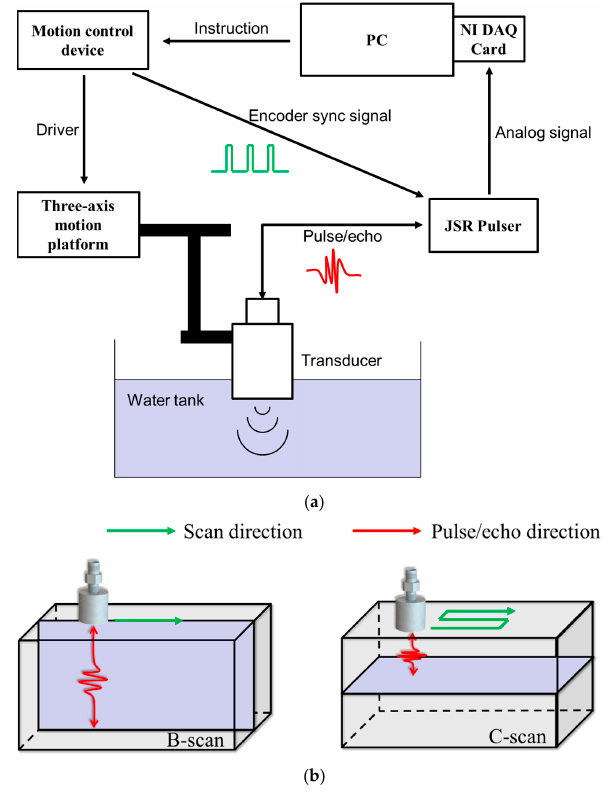
Figure 6. ( a ) Schematic diagram of scanning acoustic microscope (SAM). ( b ) Schematic diagram of B-scan and C-scan. Tungsten wires with a diameter of 10 μ m were imaged by SAM. The tungsten wires could be distinguished in the B-scan image (Figure 7a). The lateral resolution could be